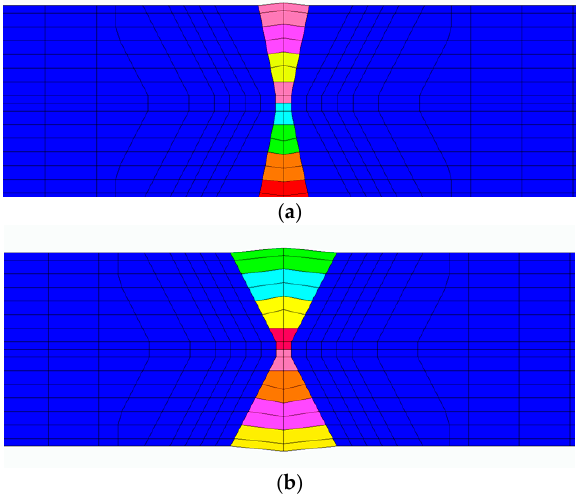
Figure 6. ( a ) Cross-section of the FEM model: NGW. ( b ) Cross-section of the FEM model: X-groove. Thermal Analysis